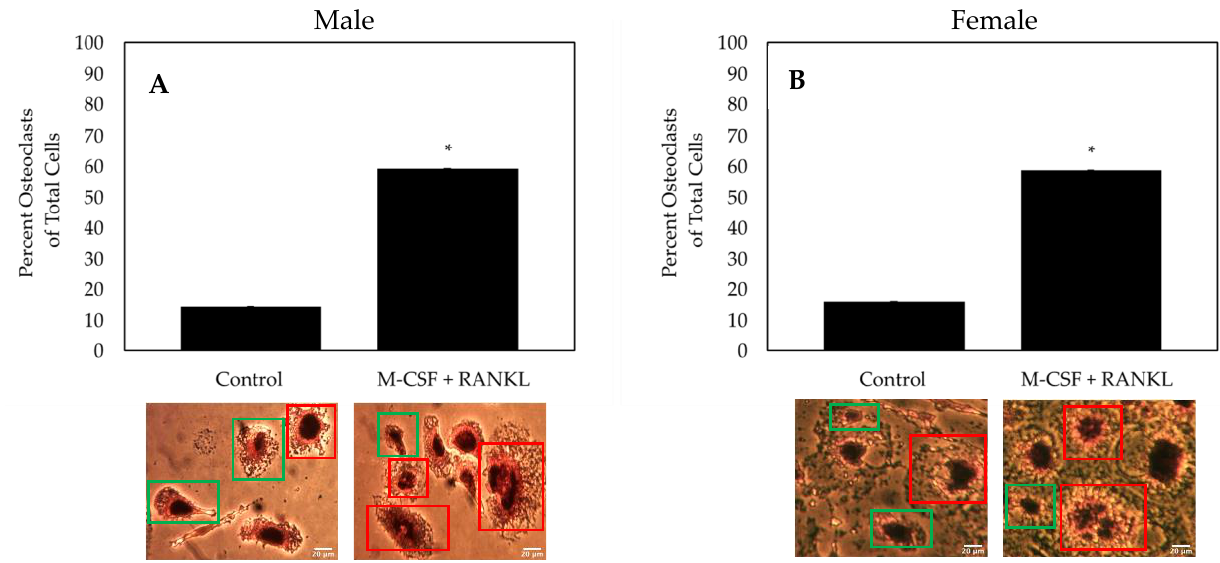
Figure 5. TRAP assay of the cells isolated from the femoral heads of OA patients. ( A ) Osteoclast count of male patients ( N = 5). ( B ) Osteoclast count of female patients ( N = 5). After stimulating cells for 14 days with M-CSF and RANKL, or M-CSF only, osteoclasts were identified as cells that stained positive for TRAP and comprised of three or more nuclei. Representative images are displayed underneath bars. Red boxes designate TRAP positive cells with more than three nuclei and green boxes denote macrophages/monocytes. Images were acquired with a 20 × objective lens and all experiments were conducted in triplicate. “*” denotes statistical significance, where p is set to 0.05.